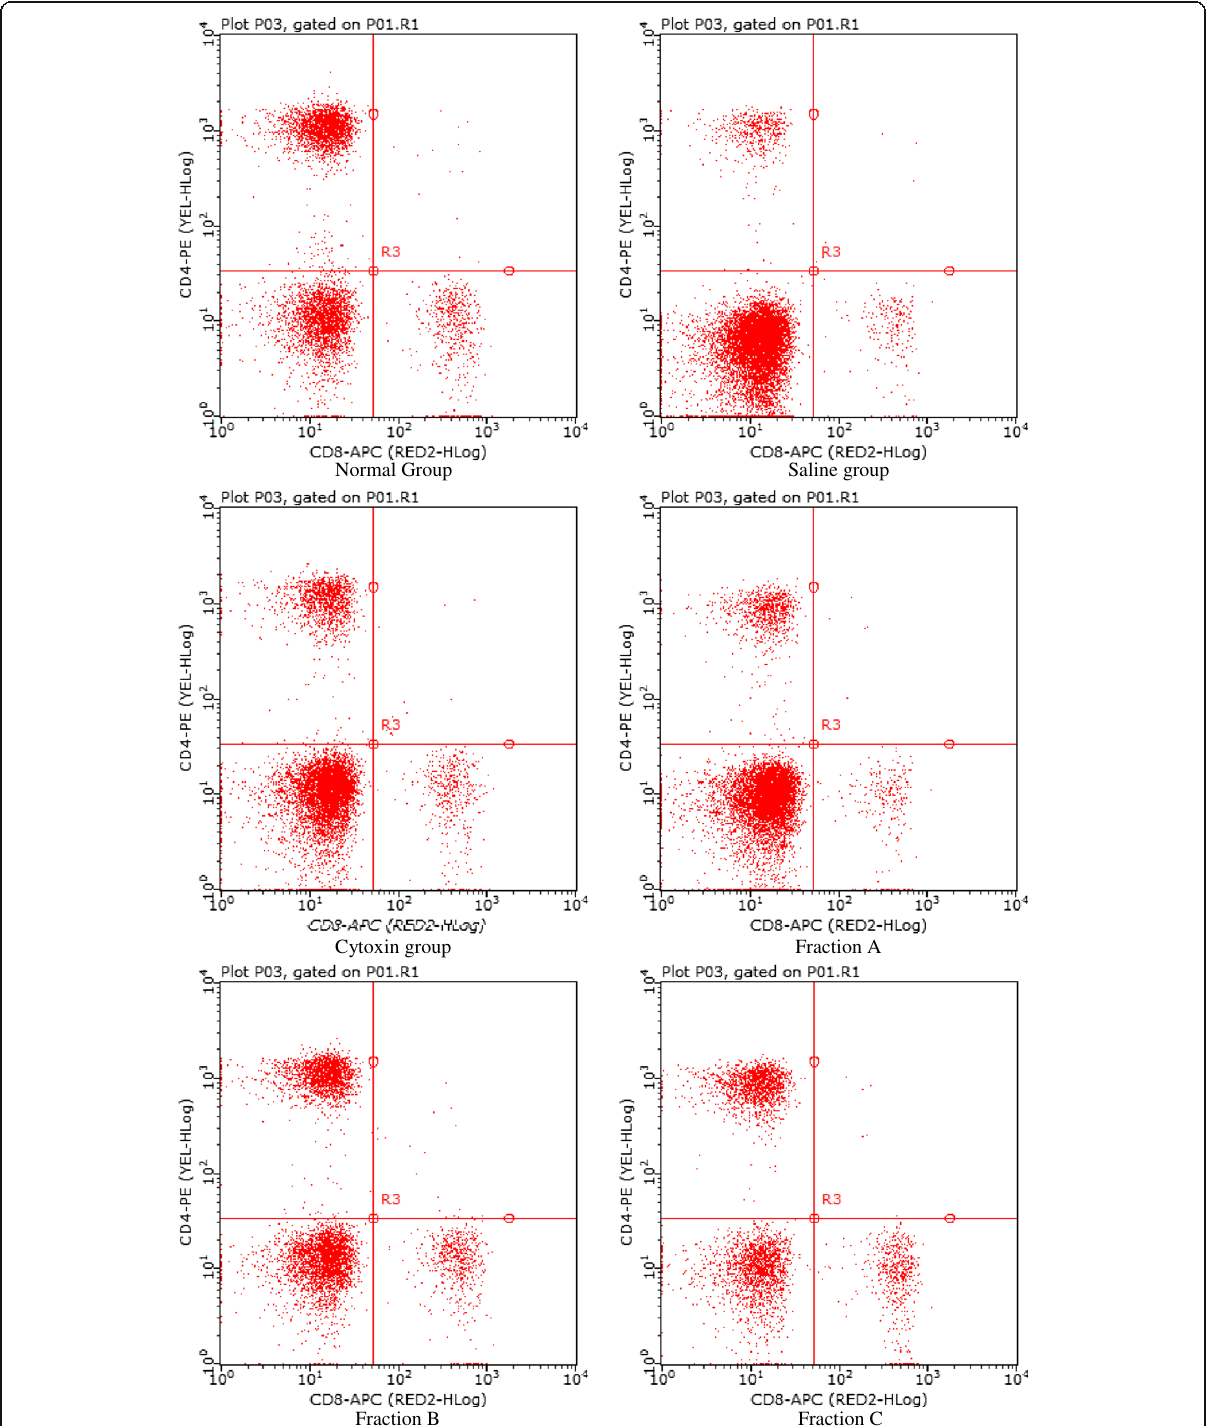
Fig. 1 Dot plots for representative treatment groups of Normal, Saline, Fraction A, Fraction B and Fraction C after treatment period. To determine immune activity of licorice polysaccharides on proliferation T lymphocytes through stimulation, flow cytometry assay was carried out. Whole blood was collected by retro-orbital puncture and stained with respective markers, CD3, CD4 and CD8. Normal group had a high percentage of CD4 and low CD8; Cytoxin group, high CD4 and low CD8; Fraction A, high CD4 and low CD8; Fraction B, high CD4 and low CD8 and Fraction C, low CD4 and high CD8 cells compared to Saline treated